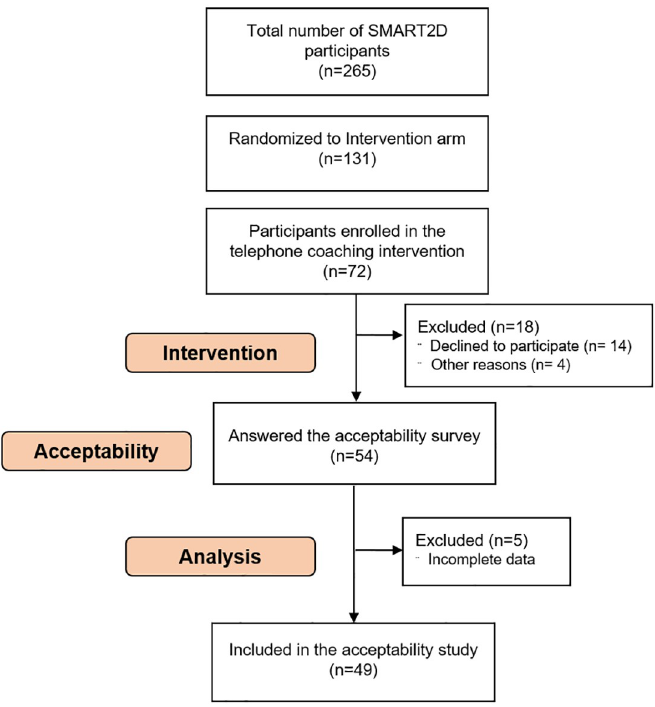
Fig 2. Flow chart describing participant sampling for assessing acceptability of the SMART2D